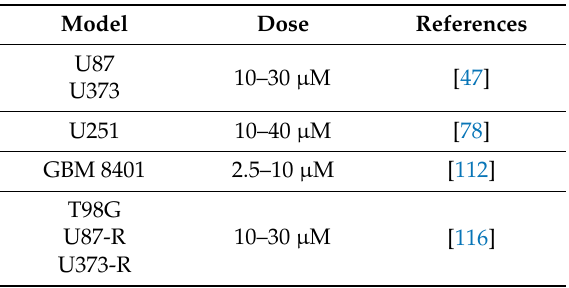
Table 2. Summary of studies focused on the anti-migration properties of SFN in